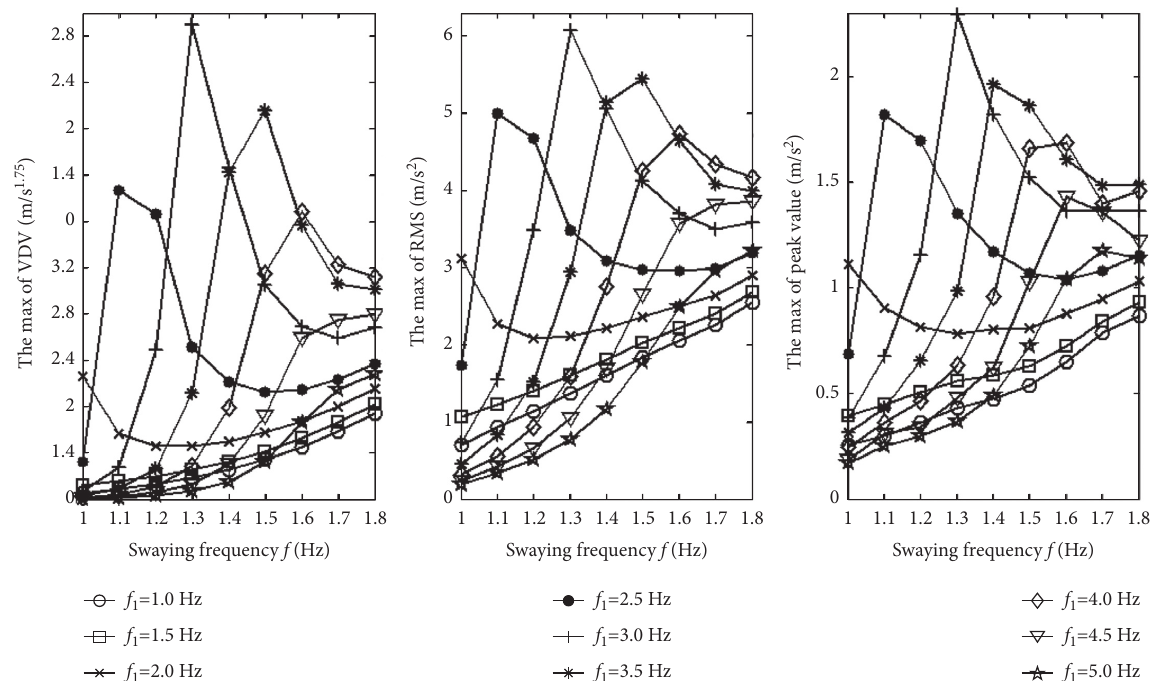
Figure 30: The max VDV, RMS, and peak values plotted against swaying frequencies.